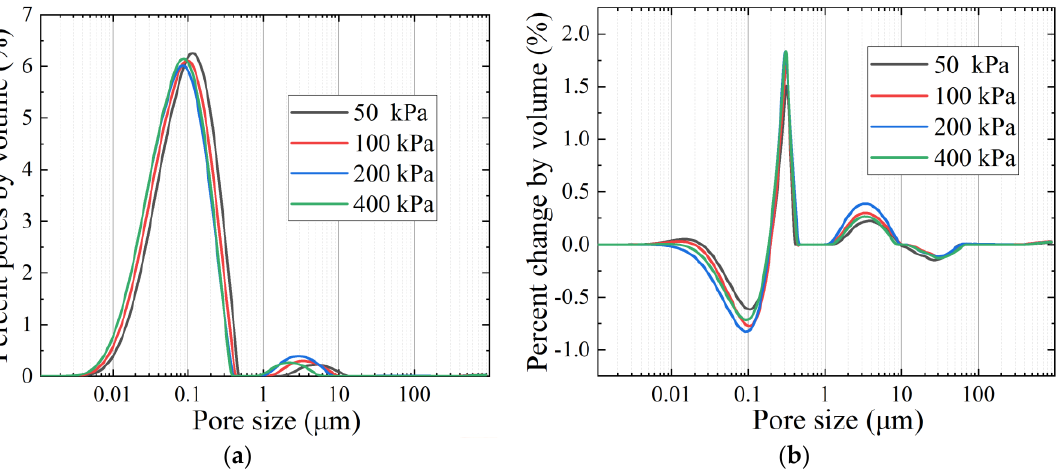
Figure 6. Effect of freezing pressure: ( a ) pore size distribution; ( b ) differences in the pore size distribution.